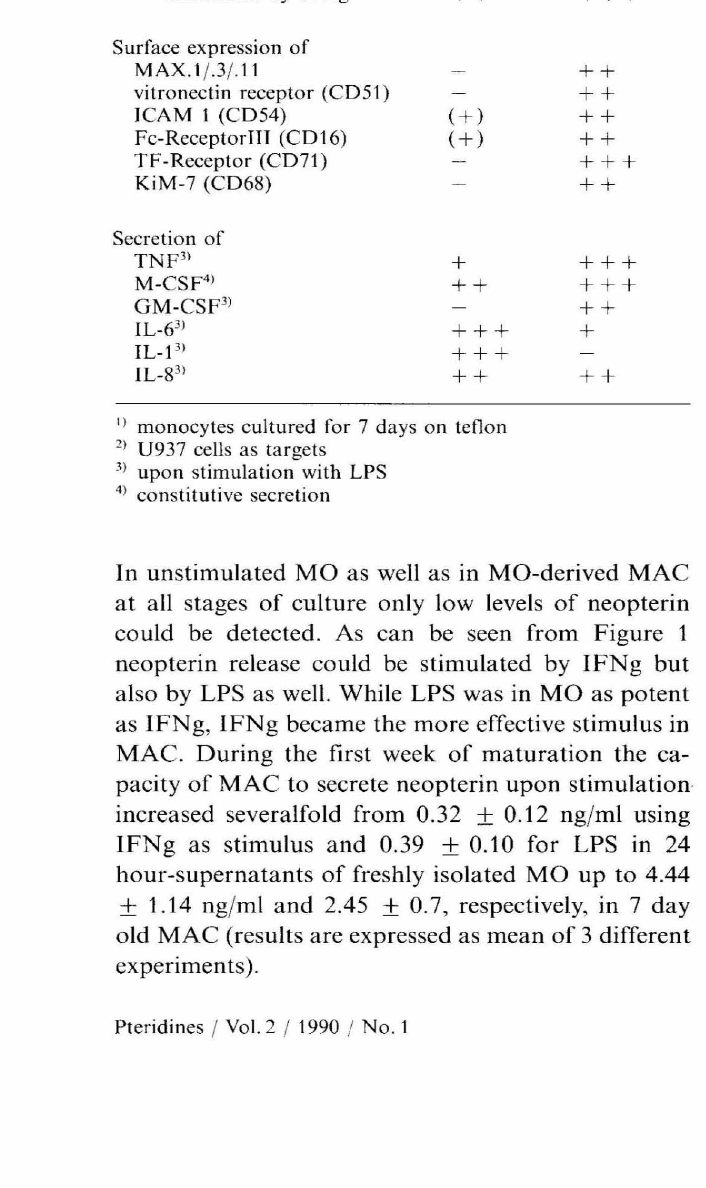
Figure 1. Regulation of constitutiw and stimulated neopterin release during MO to MAC differentiation in vitro. Elutriated MO were cultured on teflon and harvested at consecutive days as indicated. S x 10 5 cells/ml were then cultured for 24 hours with or without LPS tOO ng/ml or IFN-g 200 U m!. respectively and supernatants analyzed for neopterin. Results of one re presentative out of 4 experiments are